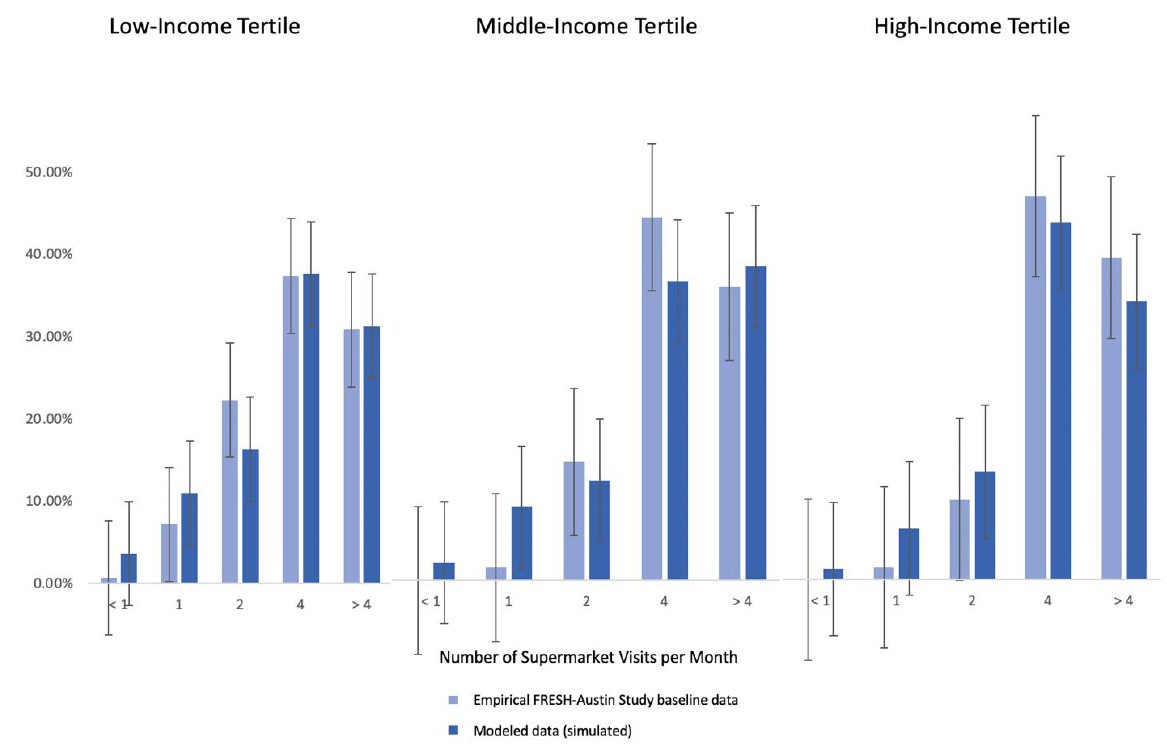
Figure 2. Agent-based model calibration based on frequency of visits to supermarkets.